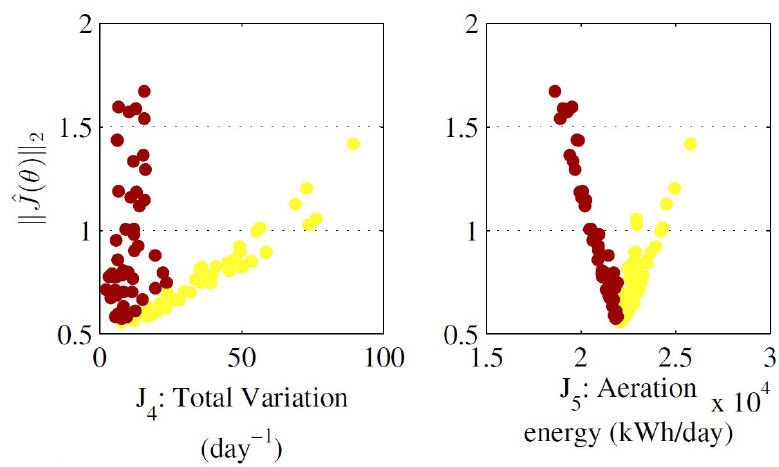
Figure 1. Pareto front approximation for MOP I.